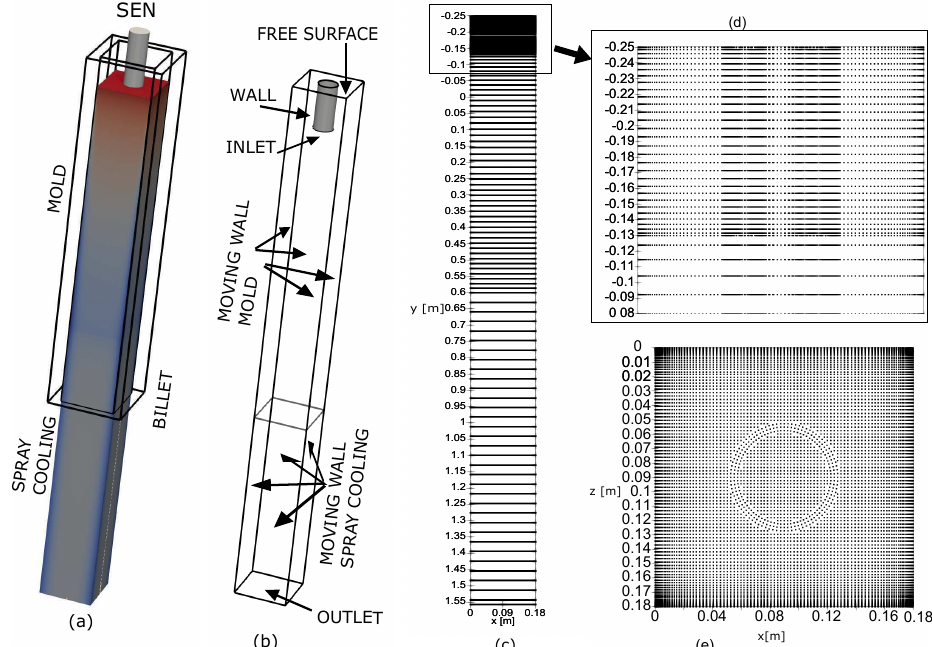
Figure 1. ( a ) A simplified schematic representation of the continuous casting (CC) of steel. ( b ) bound- ary conditions for the simplified CC model; ( c ) Domain discretization of xy and zy planes for the simplified CC model; ( d ) close-up of the top of the billet; ( e ) domain discretization of the yz plane. The RANS model, specifically the two-equation Low-Re k − ε model, is used for comparison. In this model, the turbulent kinetic energy is modelled as